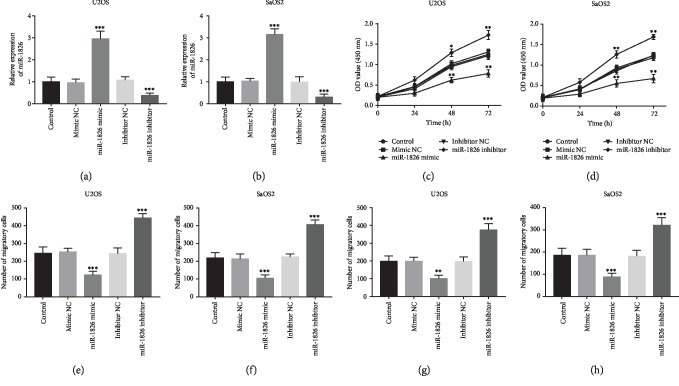
Effect of miR-1826 on OS cell proliferation, migration, and invasion in U2OS and SaOS2 cells. (a, b) The expression of miR-1826 was upregulated by the miR-1826 mimic but was downregulated by the miR-1826 inhibitor. (c, d) The CCK-8 assay indicated that OS cell proliferation was enhanced by the knockdown of miR-1826 but was inhibited by the overexpression of miR-1826. (e–h) Cell migration and invasion abilities measured by Transwell assay were facilitated by the downregulation of miR-1826 but were suppressed by the upregulation of miR-1826. ∗P < 0.05, ∗∗P < 0.01, ∗∗∗P < 0.001.